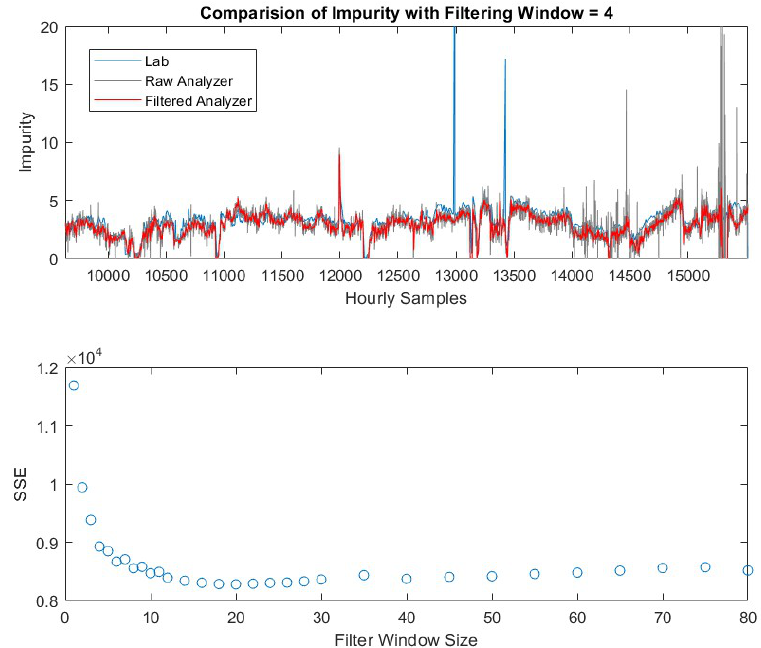
Figure 5. Comparison of hard sensor measurements (upper). Sum of Squared Error vs. di ff erent filtering window sizes (lower).